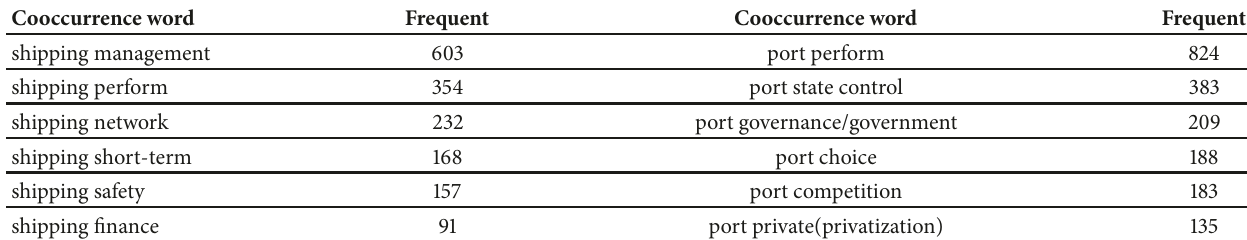
Table 11: The top 6 words cooccurrence table for port and